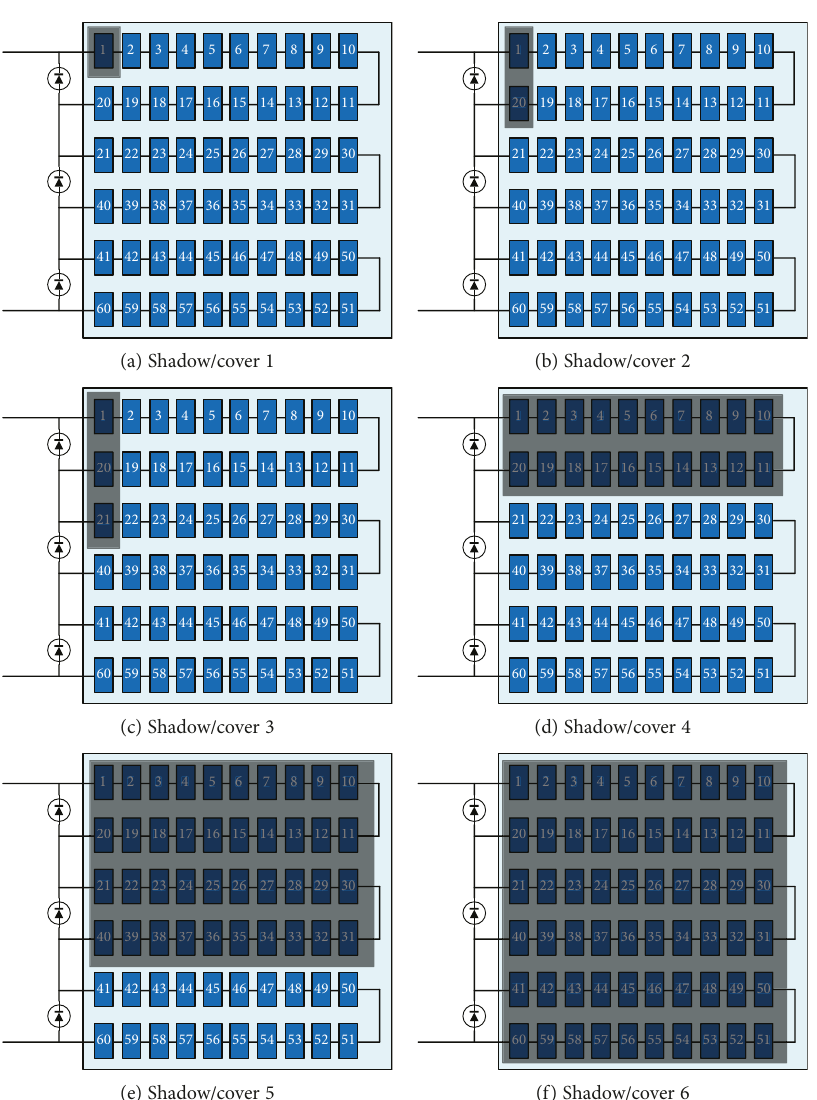
Figure 7: Setting of di ff erent shading conditions. Shading one cell/cell string, two cells/cell strings, three cells/cell strings, respectively.